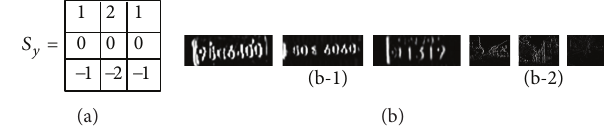
Figure 6: Normalized LP images of positive samples with boundary padding.